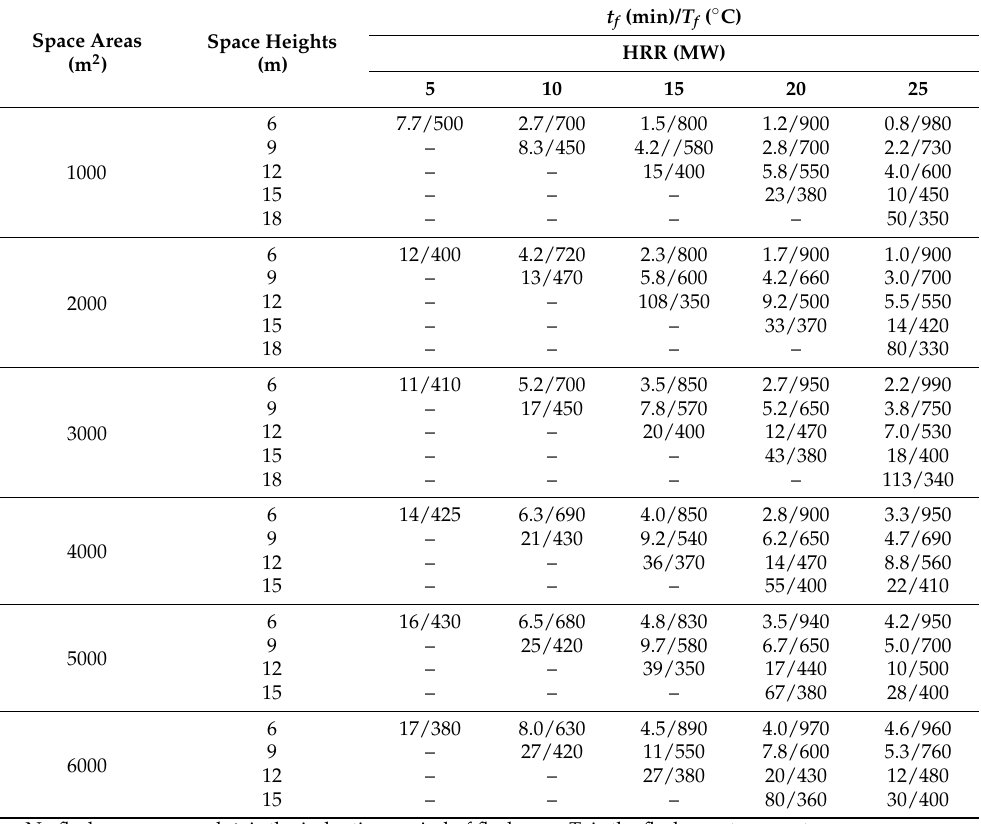
Table 10. Summary of flashover duration and flashover